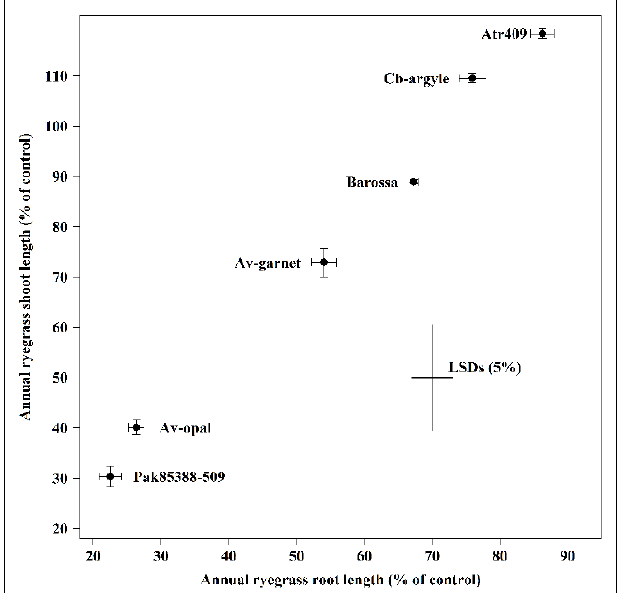
FIGURE 1 | Laboratory bioassays (ECAM) of canola ( Brassica napus ) seedling allelopathy against annual ryegrass ( Lolium rigidum ) seedlings. Data shown are the means ( n = 30; ± SE) of the root and the shoot length (% of control) of annual ryegrass seedlings. Data were pooled of three experimental units (beakers).The cross indicates significant difference between the genotypes within two variables (root and shoot; P < 0.05, ANOVA with post hoc Fisher-LSD-test).The Pearson correlation coefficient ( r ) is 0.99 ( P <